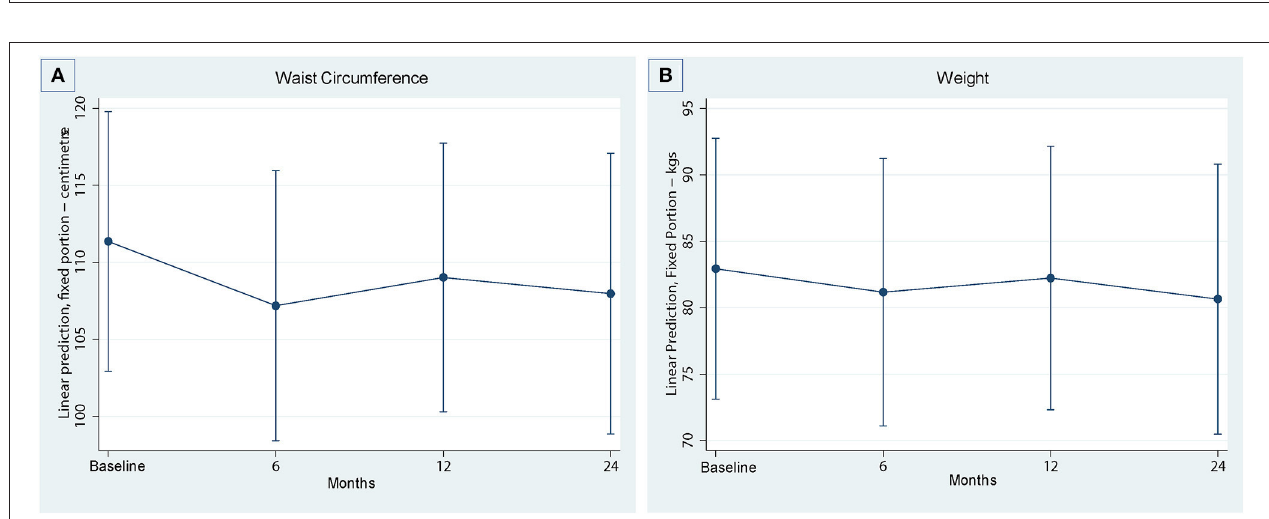
FIGURE 3 | Cardiovascular outcomes over four timepoints. (A) Waistcircumference, (B) Weight.